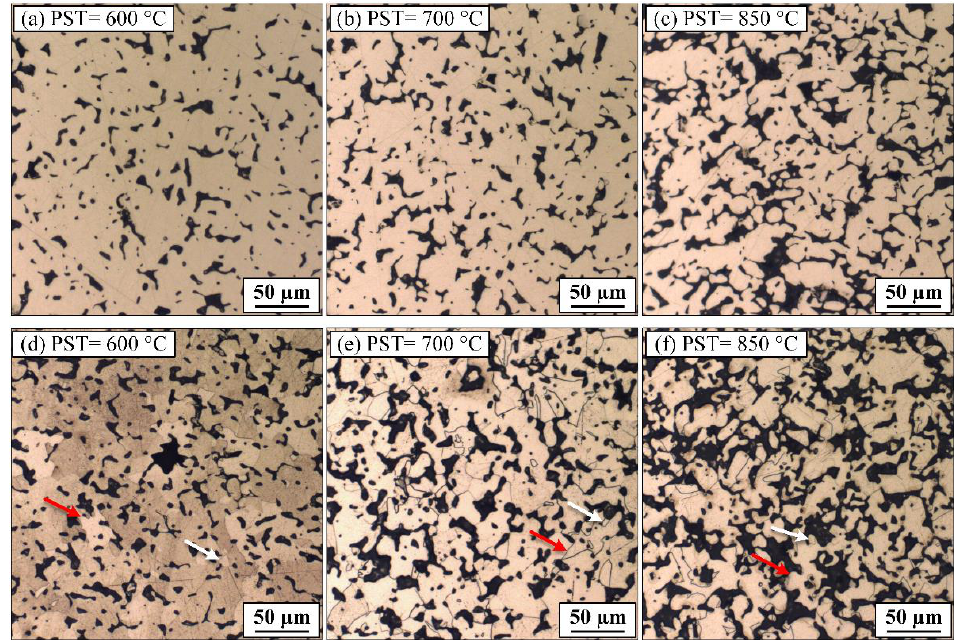
Figure 9. Optical micrographs of ( a – c ) as-polished, ( d – f ) etched specimens sintered at 1250 °C under hydrogen atmosphere following different pre-sintering temperatures.